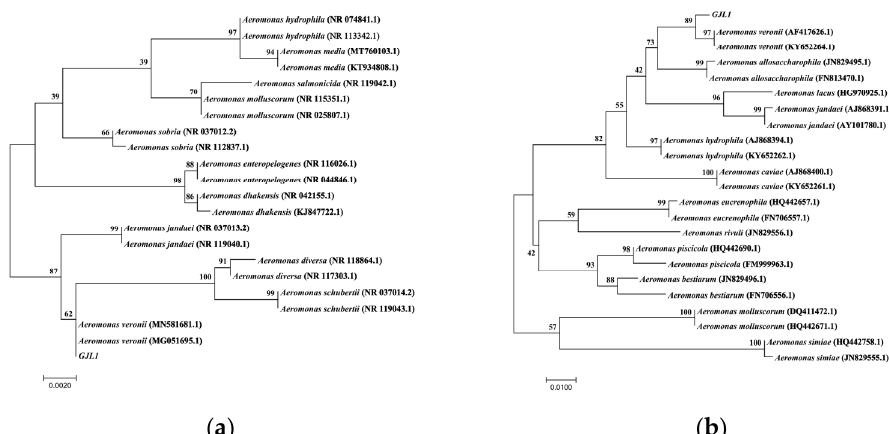
Figure 4. ( a ) Phylogenetic tree of Aeromonas species based on 16S rRNA sequences. ( b ) Phylogenetic tree of Aeromonas species based on gyrB sequences. Bootstrap values (based on 1000 replicates) > 50% are given at the branch points.